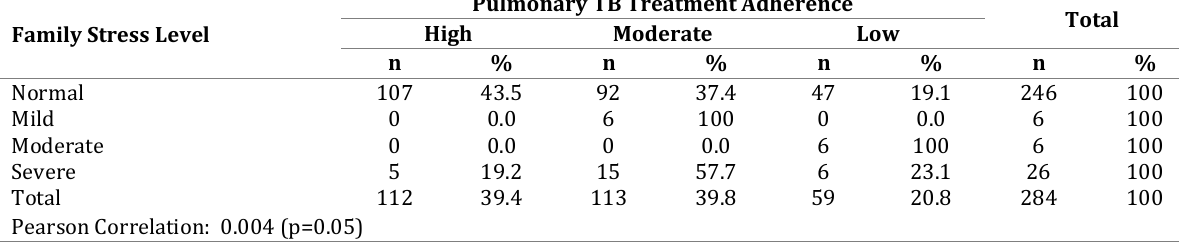
Table 2. Effects of Family Stress on Adherence with Pulmonary TB Treatment Family Stress Level